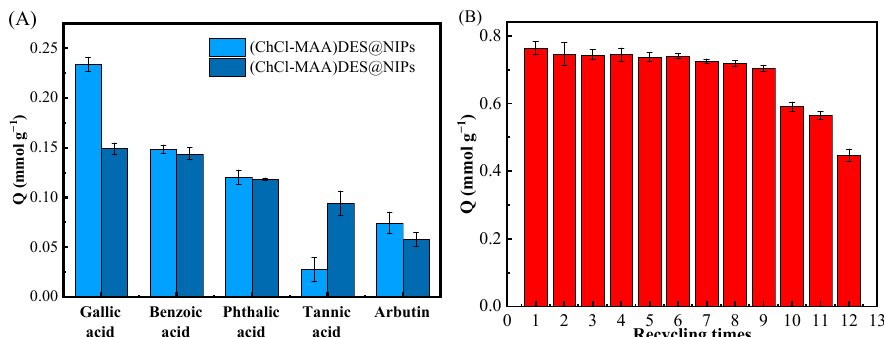
Figure 8. Competitive adsorption of GA, benzoic acid, phthalic acid, tannic acid, and arbutin on (ChCl-MAA)DES@MIPs or (ChCl-MAA)DES@NIPs at 298 K ( A ); the recycling times of adsorp- tion/desorption of GA by (ChCl-MAA)DES@MIPs ( B ). Table 5. Imprinting factor α and isolate factors β of DES@MIPs with GA as template. Factors